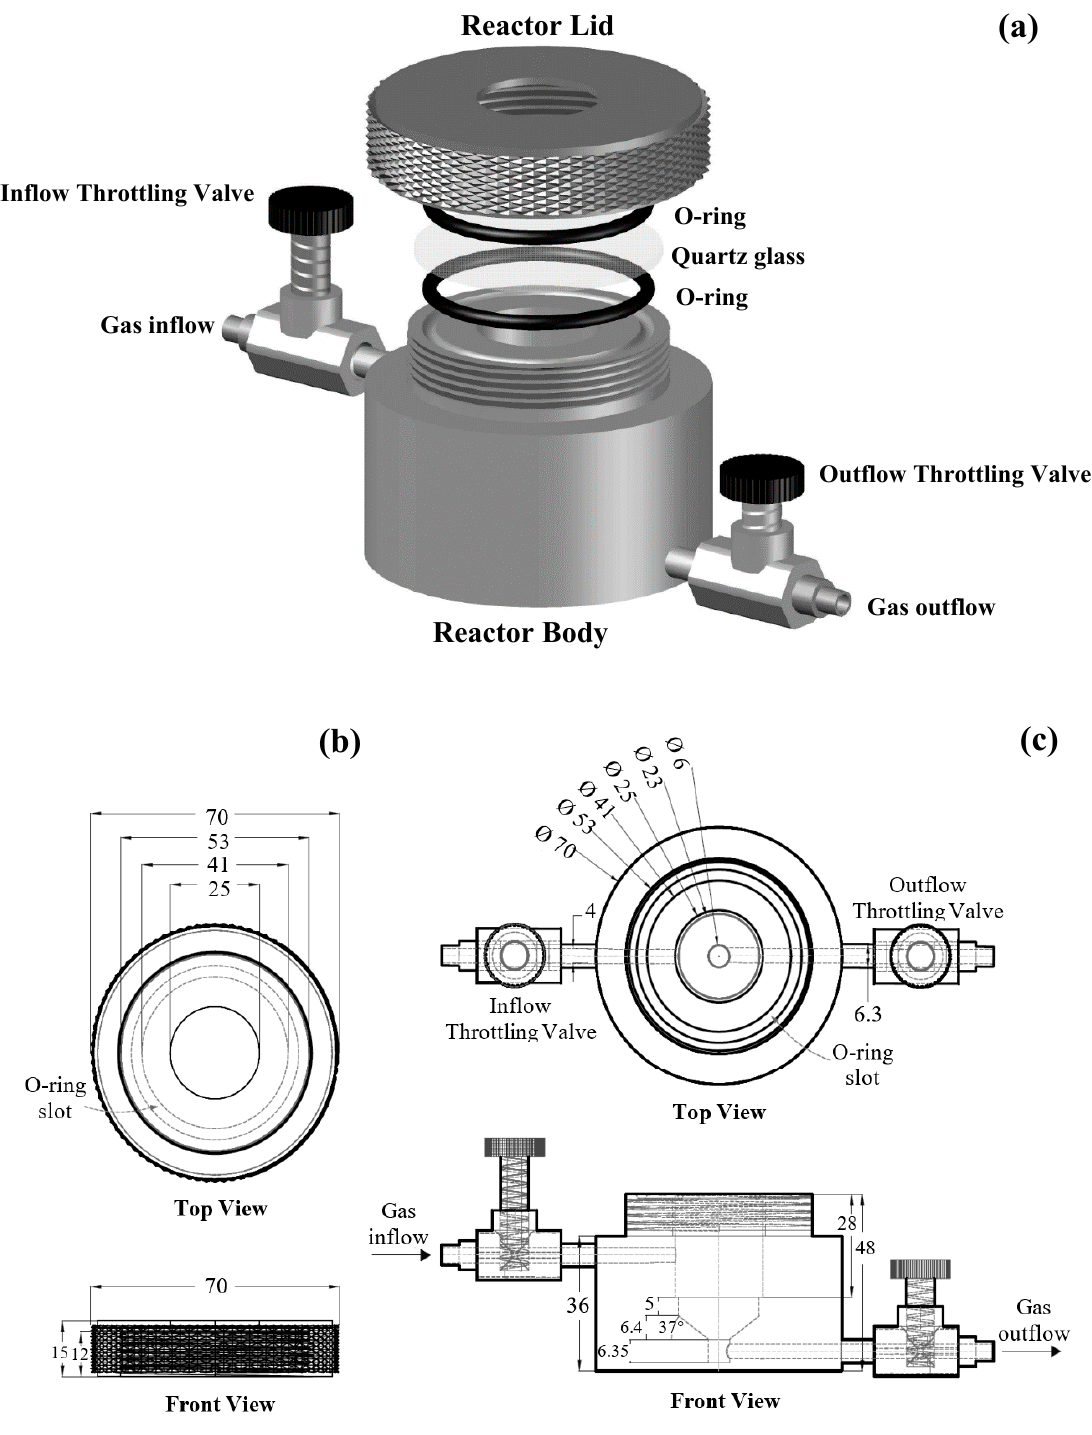
Figure 6. Reactor diagram and its blue prints, ( a ) Complete reactor diagram, ( b ) Lid dimensions, and ( c ) Reactor body dimensions.